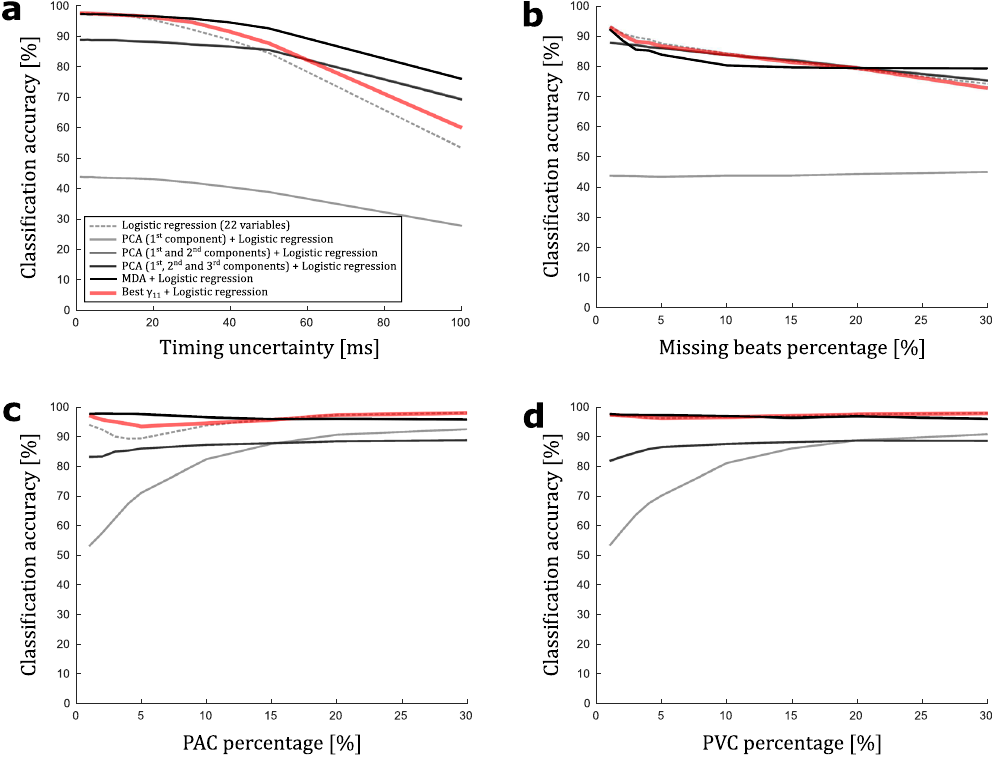
Figure 8. Impact of variable selection technique on classification accuracy. Classification accuracy of multivariate logistic regression in discriminating the Normal Sinus Rhythm (NSR, N = 4,500) and Atrial Fibrillation (AF, N = 2,900) states for 1-min RR interval time series applied to noisy datasets plotted against ( a ) timing uncertainty applied to each R peak detection, ( b ) missing beats percentage applied to each RR interval time series used, ( c ) premature atrial contractions (PAC) percentage applied to each RR interval time series used, ( d ) premature ventricular contractions (PVC) percentage applied to each RR interval time series used. In ( a – d ), the management of input variables candidates consisted of no preliminary selection (22 input variables, dotted line line), selection of the first component (1 input variable that is a combination of the 22 available variables, light grey), selection of the 2 first components (2 input variables that are a combination of the 22 available variables, medium grey), and selection of the 3 first components (3 input variables that are a combination of the 22 available variables, dark grey) of a principal component analysis (PCA), selection of the factorial axis of the multiple discriminant analysis (1 input variable that is a combination of the 22 available variables, black), and selection of the best γ -value (11 input variables among the 22 available variables,